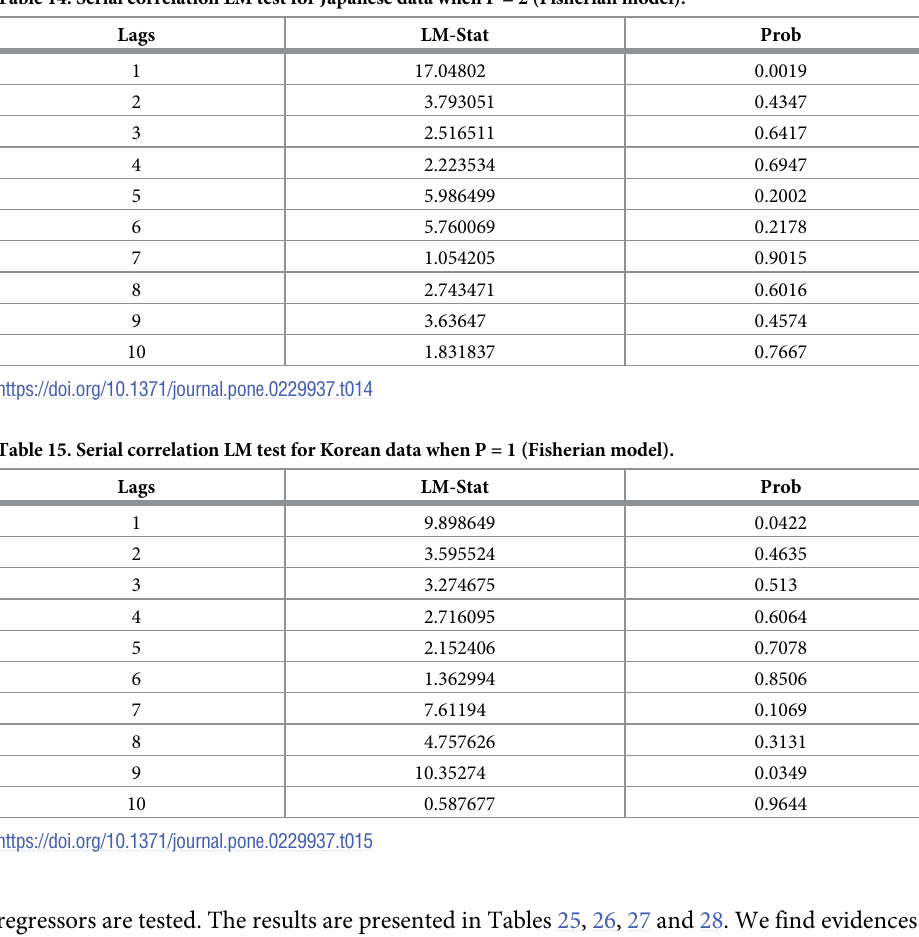
Table 14. Serial correlation LM test for Japanese data when P = 2 (Fisherian model).